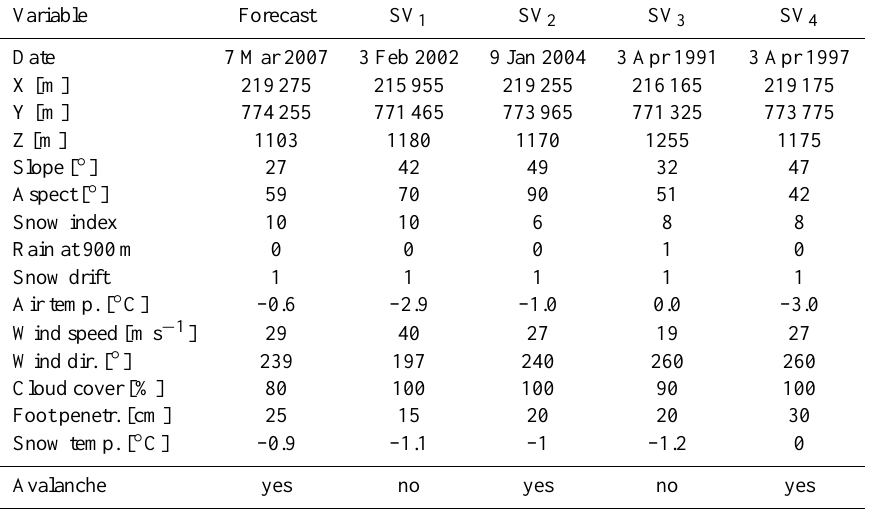
Table 6. Descriptive interpretation of the forecast for a particular location-conditions is provided with the closest Support Vectors: the 4 most relevant historical reference situations found by the SVM model for the current “Forecast” are listed in columns “SV 1 ” to “SV 4